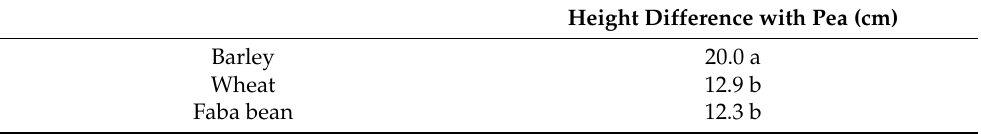
Table 5. Height differences between the companion crops and pea in each intercropped plot in trials Cord1-18(i), Alm1-19(i) and Cord2-19(i). Different letters on the same crop mean significant differences (LSD test, p <